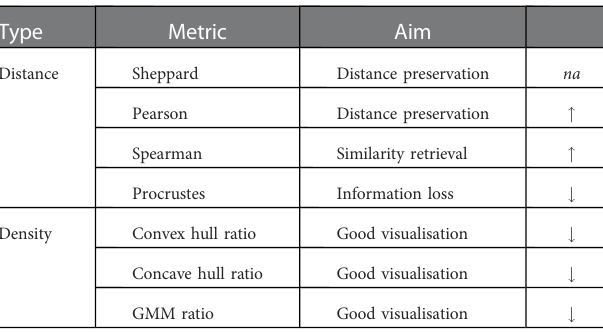
TABLE 4 Evaluation metrics.